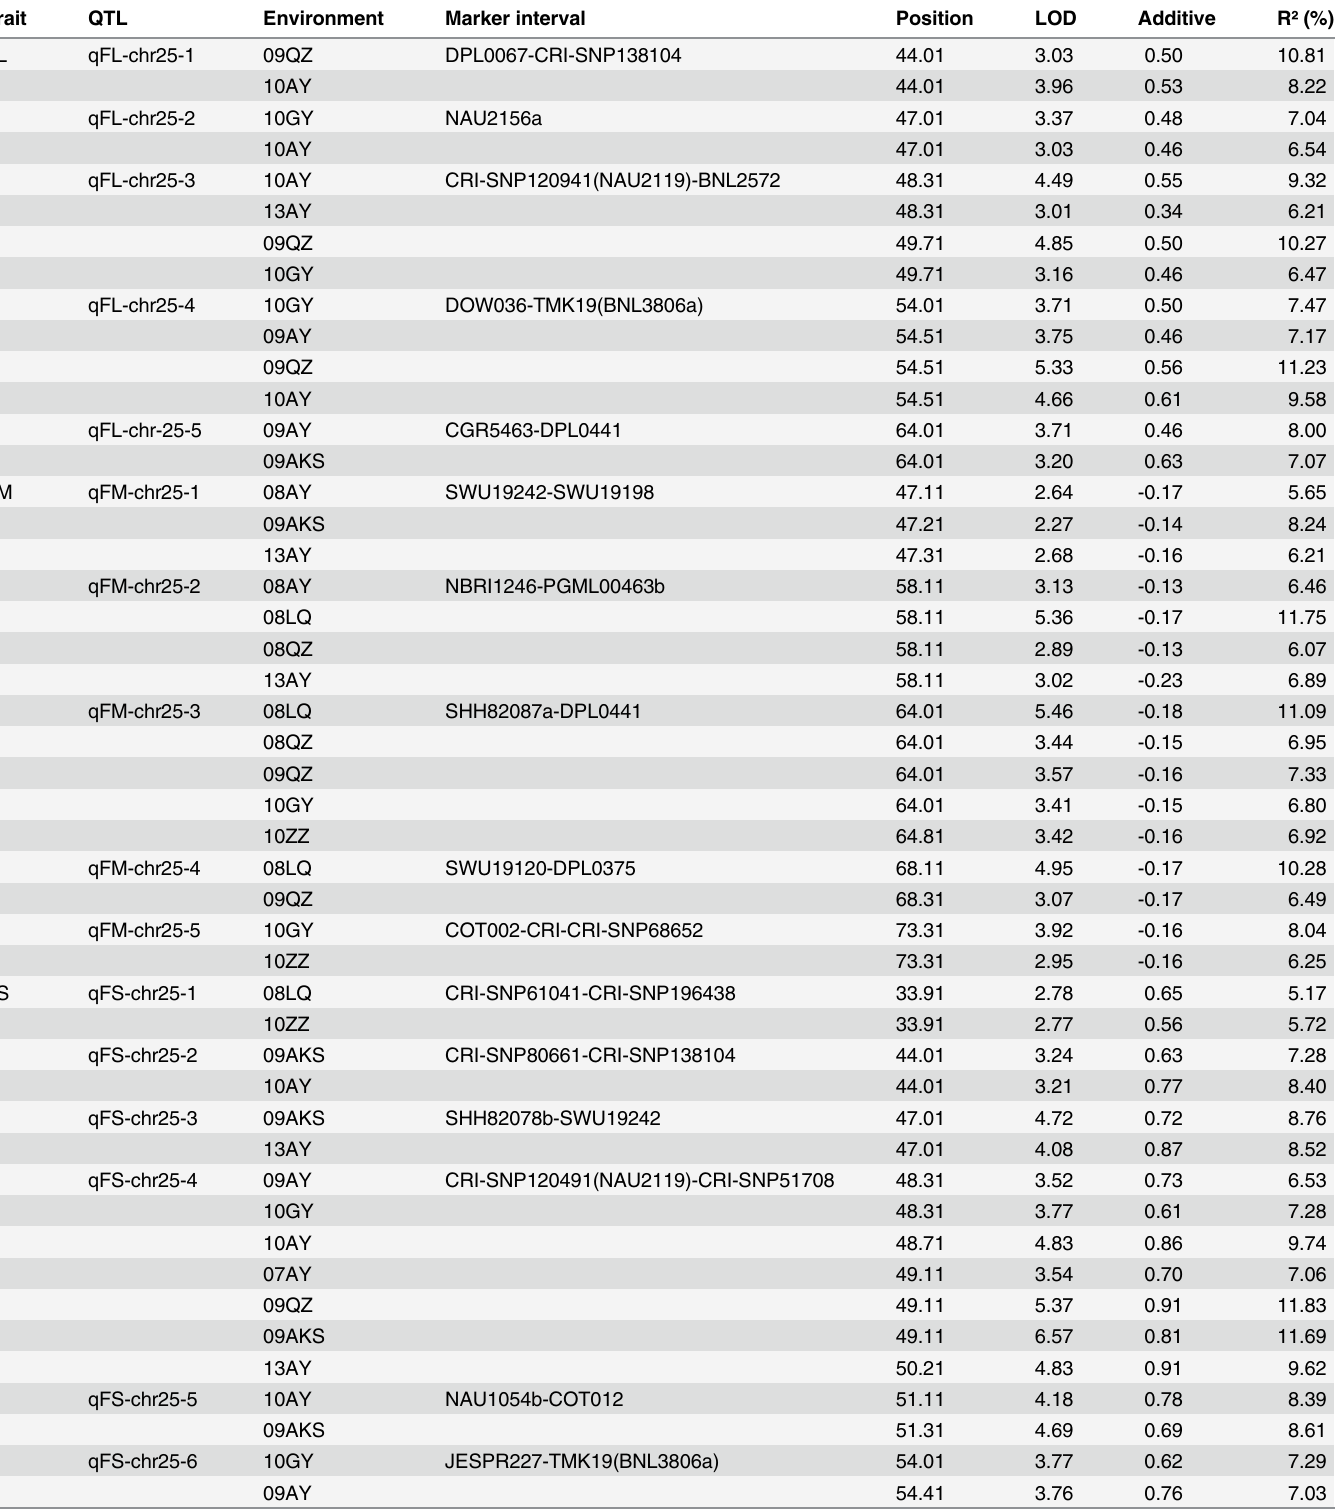
Table 3. Stable QTLs for fiber length, fiber micronaire and fiber strength identified in the RILs.